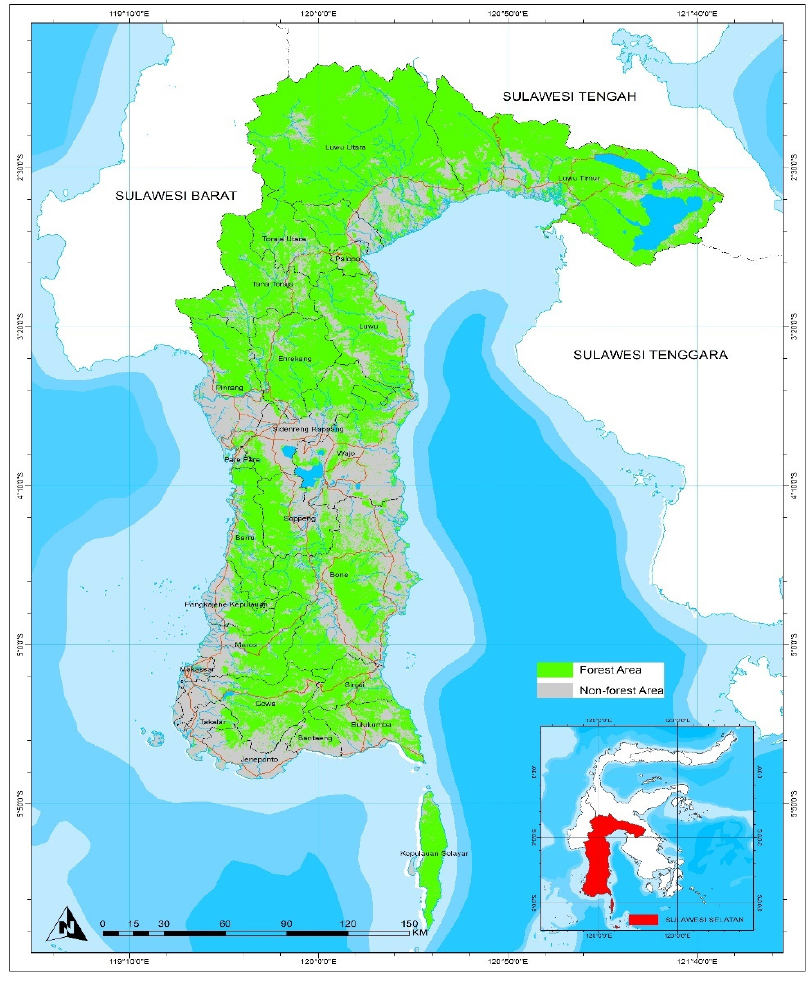
Figure 4. Map of forest distribution in Sulawesi Selatan Province.